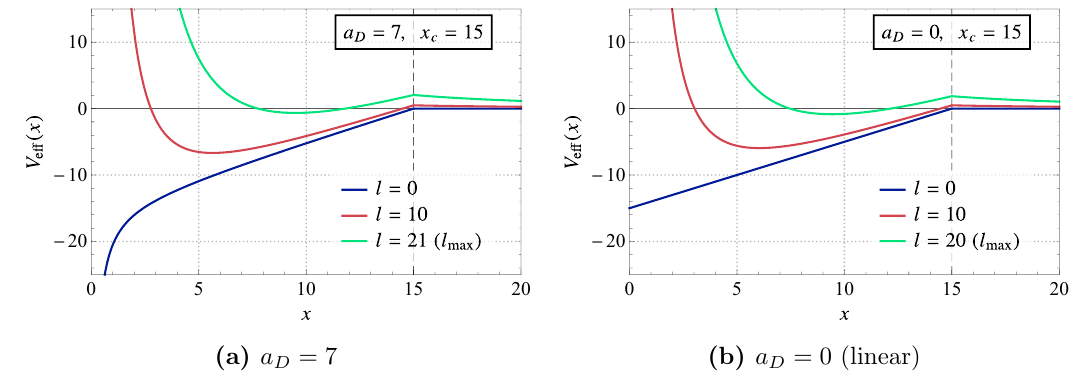
Figure 9. The e(cid:11)ective potential V e(cid:11) ( x ) with x c = 15 ( m X ’ 125(cid:3) D ), for three values of l . In the left (cid:12)gure, a D = 7, which corresponds to (cid:22) (cid:11) D = 0 : 3, while a D = 0 in the right (cid:12)gure. The largest l in each (cid:12)gure corresponds to the upper-bound on l of the bound states. Note that the plots for l = 0 correspond to V ( x ) in eq. (A.5).